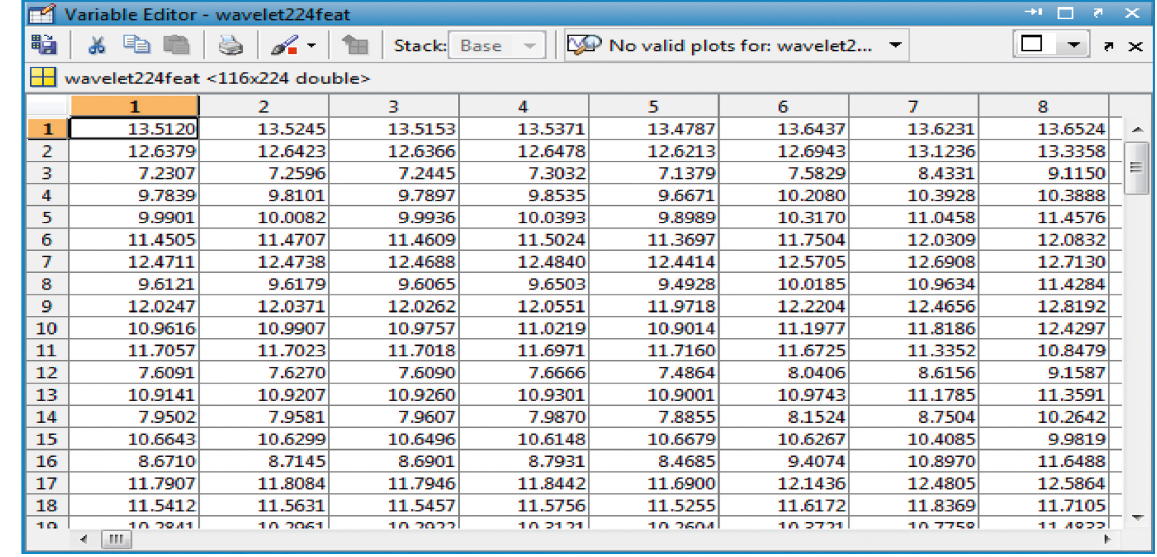
Figure 10: A snapshot of a portion of wavelet features.